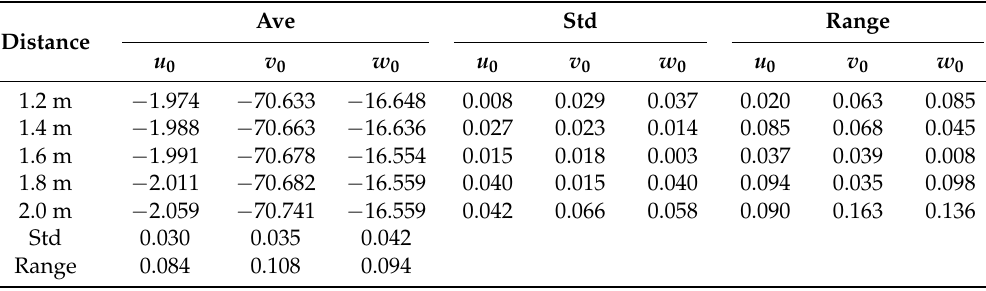
Table 2. Results of self-calibration for ( u 0 , v 0 , w 0 ) at different distances (mm).